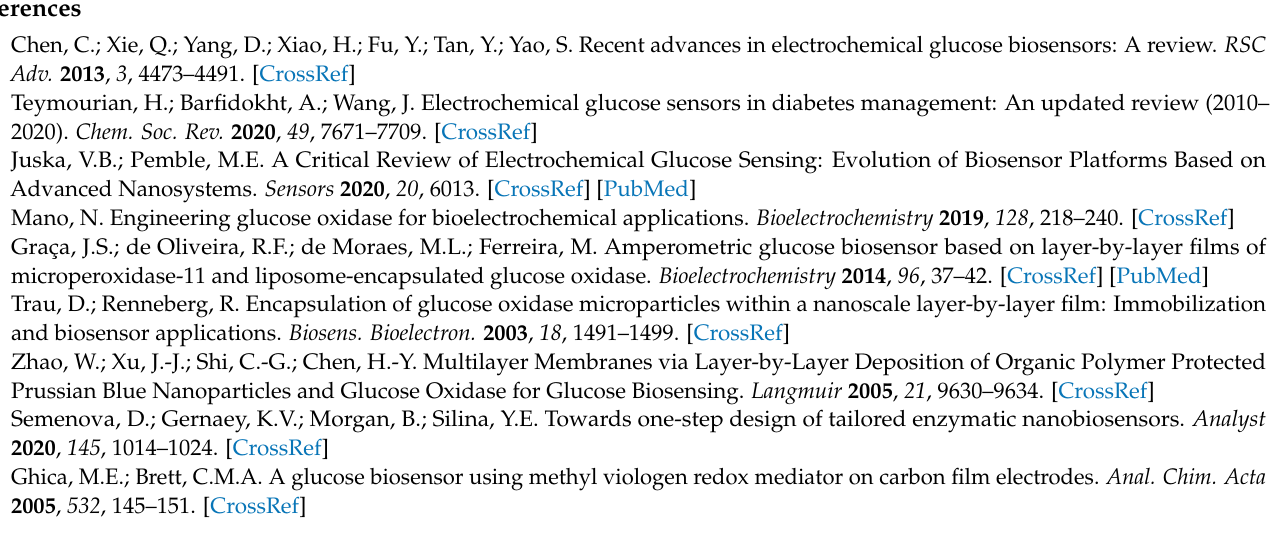
Figure S2: Selected glucose calibration curves illustrating the influence of the gel content on the shape of the curves (current was recorded at 5 s): (a)—shown for the gels with and without addition of sodium alginate, (b)—shown for the gels with addition of Aerosil 380; (c)—shown the S-type calibration for low content of FC or GOx; Figure S3: LDI-MS full scan TIC-chromatograms (all ions) obtained from SPE covered by conventional and modified gels via screen printing approach; Figure S4: Impact of the thickness of functional layer on sensitivity of glucose test-strips based on 10CMC/25ALG/200FC/9GOx ( 1 ) and 10CMC/50AS/200FC/9GOx ( 2 ) gels; Figure S5: Current degradation recorded from glucose test-strips with the functional 10CMC/25ALG/200FC/24GOx (CitB, pH 6.0) layer after a short stress-heating test at 120 ◦ C for 30 s (black curve) and consequent storage at 55 o C for 1–4 weeks (other colours). Figure S6: LDI-MS spectra obtained from SPE modified by FC in PPBI after storage for 3 days in the access of light at 55 ◦